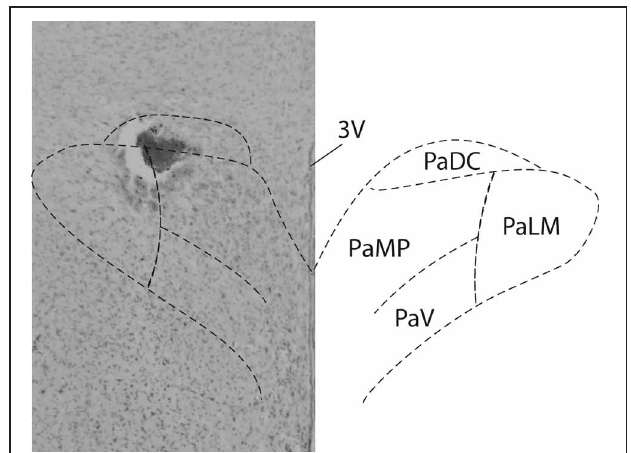
FIGURE 1 | PVN injection site. Brightfield photomicrograph (Left) indicates the location of an injection site within the PVN of an individual rat. 100nl of the dye Pontamine sky blue was injected at the conclusion of all experiments. A schematic of the PVN (Paxinos and Watson, 2007) is superimposed for